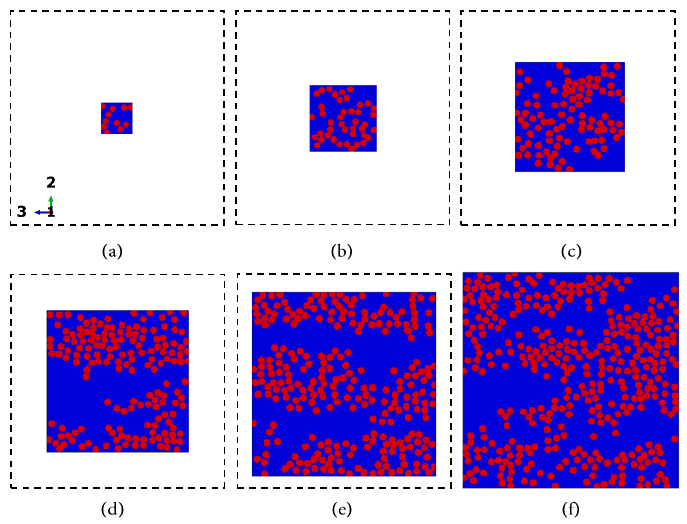
Figure 16. Discretized cropped regions with size δ = 10 ( a ), δ = 20 ( b ), δ = 30 ( c ), δ = 40 ( d ), δ = 50 ( e ) and δ = 60 ( f ). For all the finite element models, the element size corresponds to one pixel size according to their respective computed microstructures.